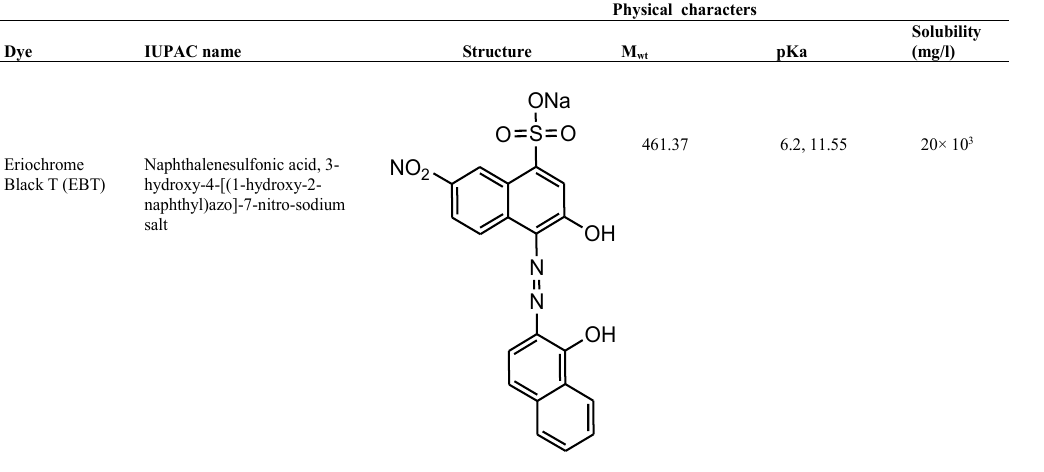
Table 1: Chemical structure of the model EBT dye